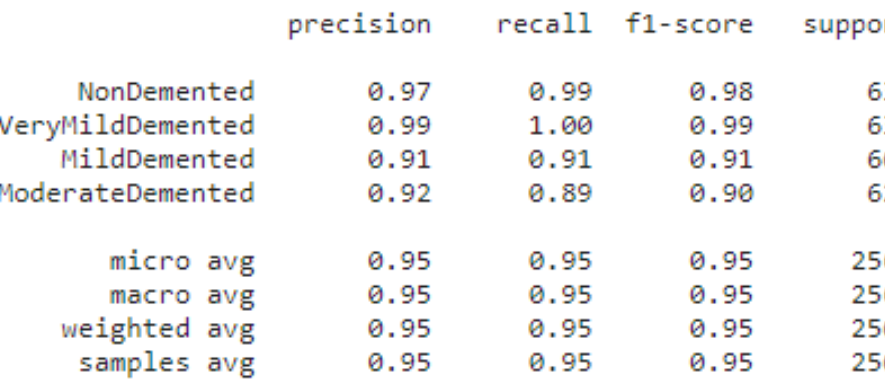
Figure 17. Visualize Form of Diagnostic Test of CNN Algorithm .